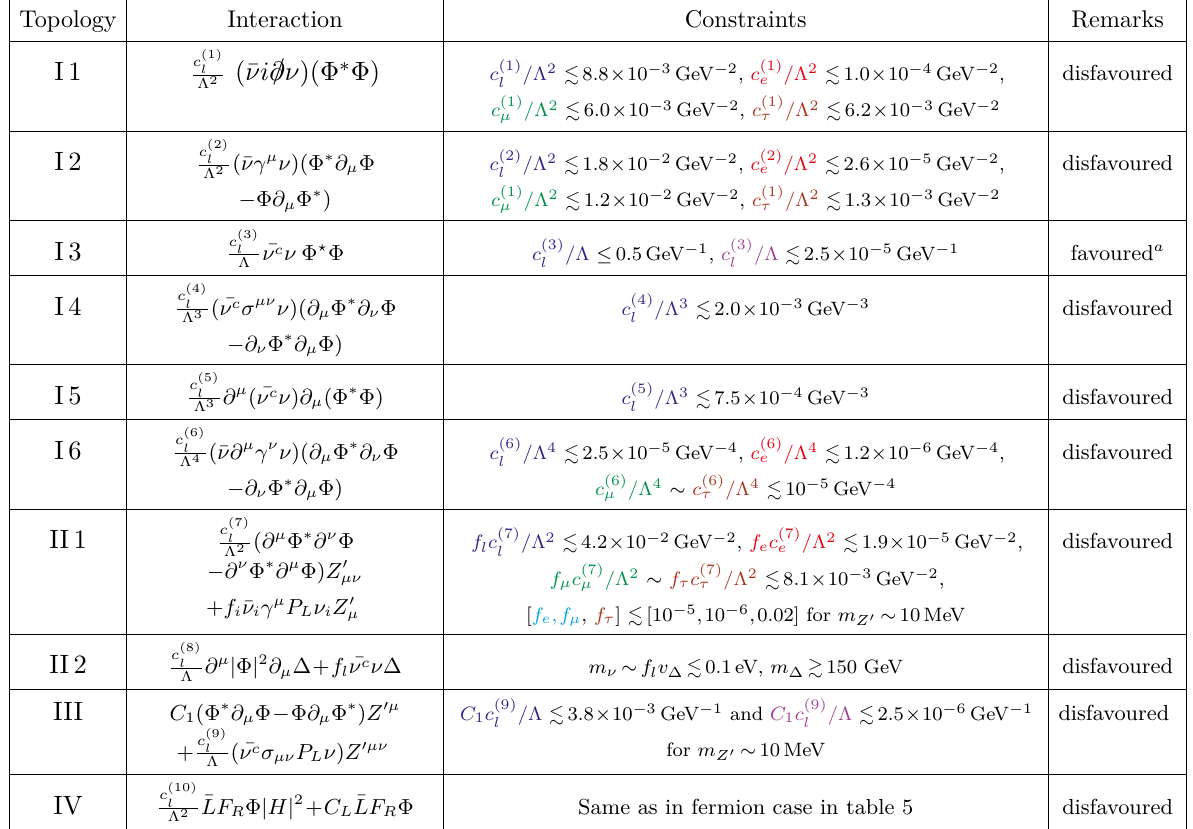
Table 1 . Summary of neutrino-DM effective interactions. c l and c e,µ,τ represent the coefficients of interactions for the gauge non-invariant and gauge-invariant forms respectively. The colour coding for the constraints is: Z → inv , LEP monophoton + /E , Z → µ + µ − , Z → τ + τ − , BBN and ( g − 2) e,µ . T We also remark whether the interactions are favoured in context of the 1% flux suppression criteria.